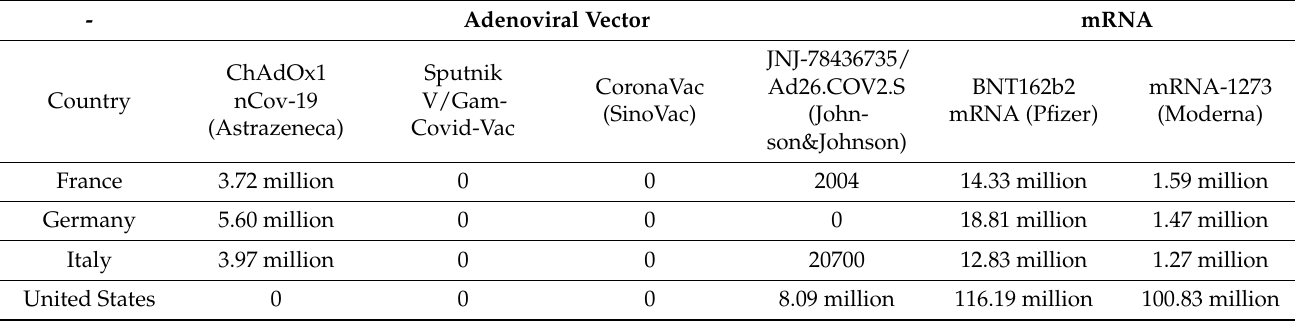
Table 5. Total administrations of anti-SARS-CoV-2 vaccines according to selected countries and type of vaccine. Data are only available for countries which provided official reports. Time span is 24 December 2020–26 April